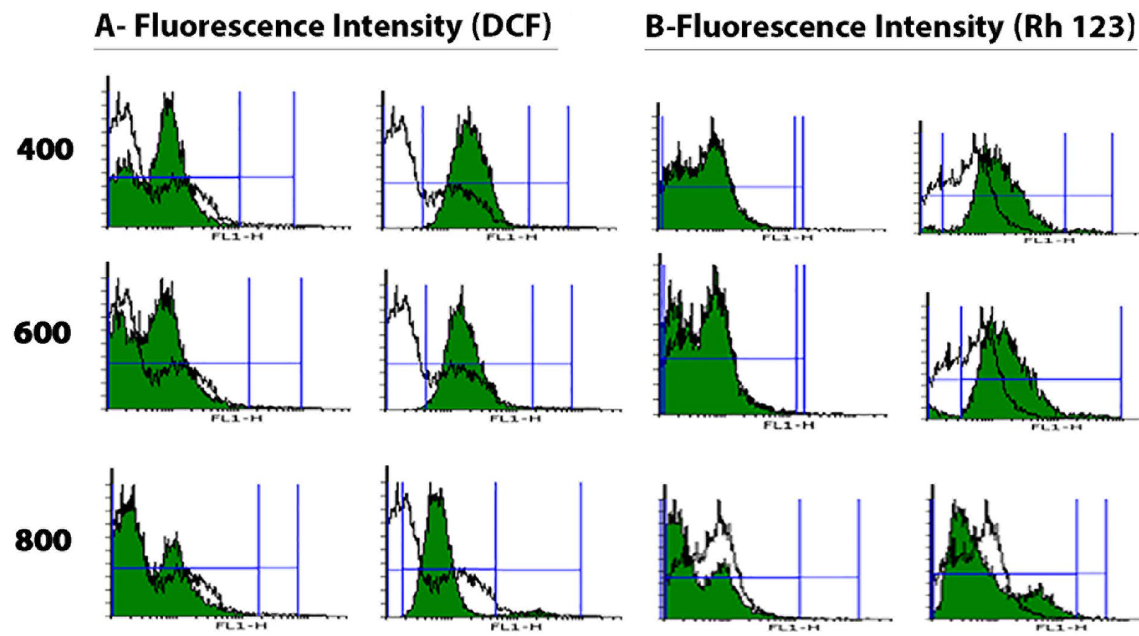
Figure 3. Flow cytometry graphs showing the effect of heterostructure quantum dots on ( a ) ROS formation and ( b ) MMP of lymphocytes